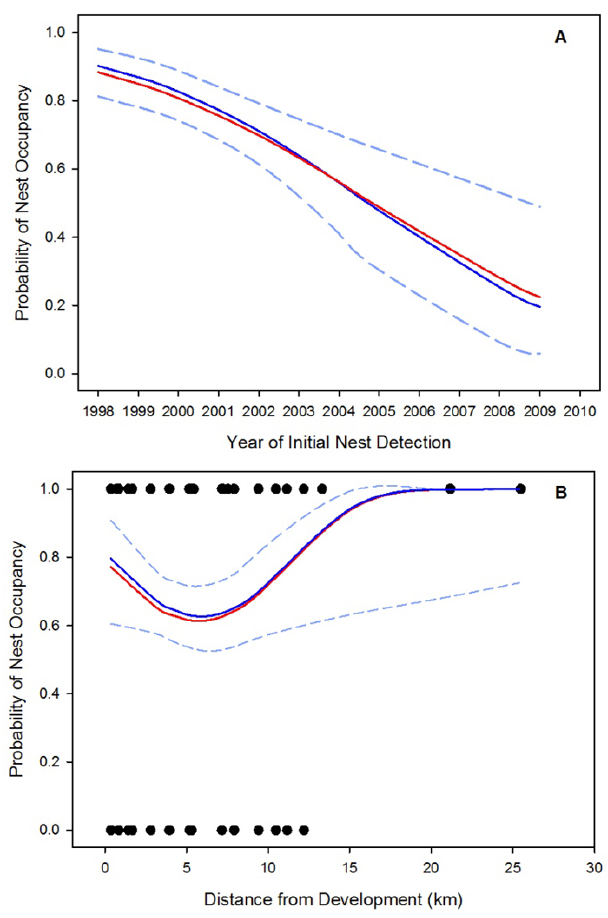
Fig. 4 . Probability predictions (± 95% CI; blue dash) of nest hatch for Peregrine ( Falco peregrinus ) and Gyrfalcon ( Falco rusticolus ; blue line) in the Lac de Gras study area, during 1998 to 2010, based on the top ranked model (Table 3) for the effects of year (temporal trend; A) and distance (B). Shown is the mean response after controlling for other model effects. Also shown are raw binomial observations (circles) by distance and the predictions for Peregrine Falcon (red